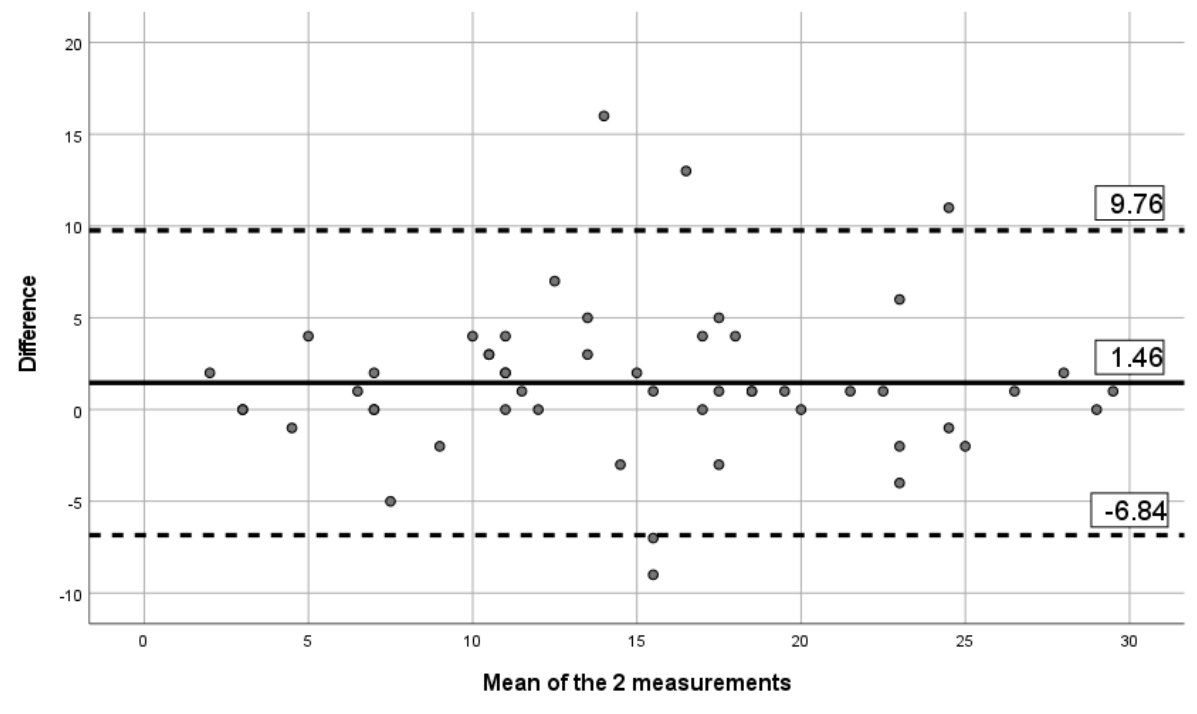
Figure 4. Bland-Altman limits for the painDETECT questionnaire between the 2 assessments using the app.